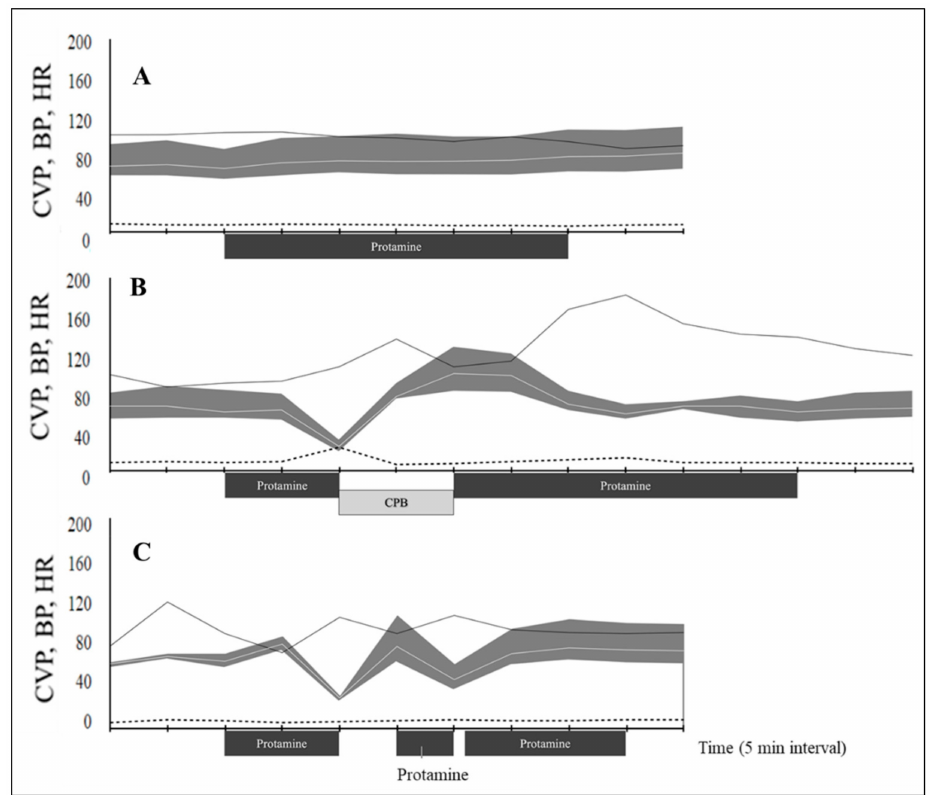
Data are presented as mean (SD). Variables were reported every 5 min starting from 10 min before the start of protamine infusion to 40 min after the start of administration. Dunnett’s test was used to compare values for variables during protamine infusion with values before protamine infusion in program R (version 3.3.2; R Development Core Team 2016), with a significance set at p < 0.05. No significant change was observed in all